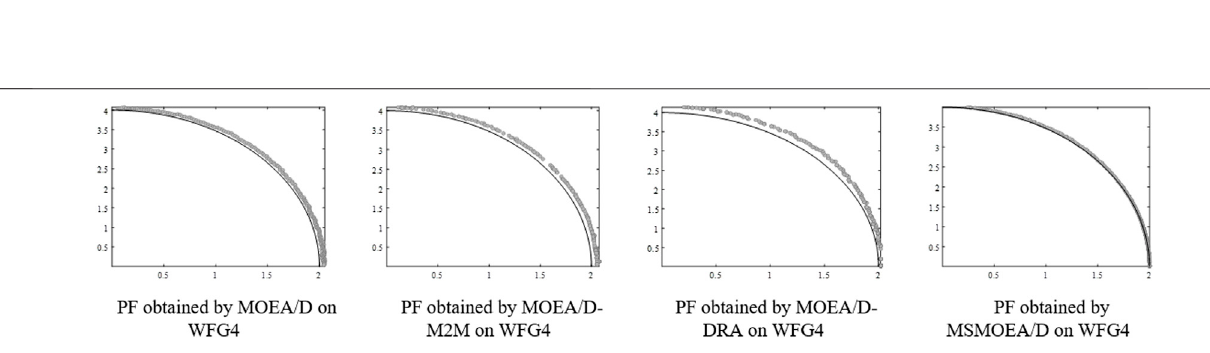
Frontiers in Energy Research |